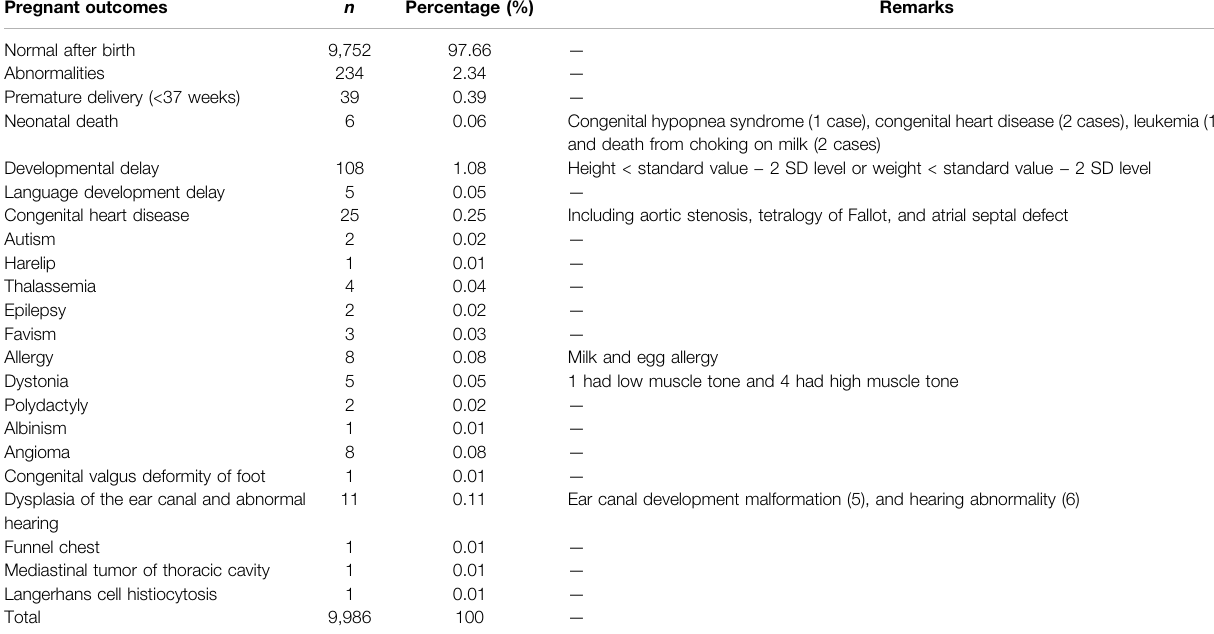
TABLE 6 | Pregnancy outcomes in 9,986 women with negative NIPS. Pregnant